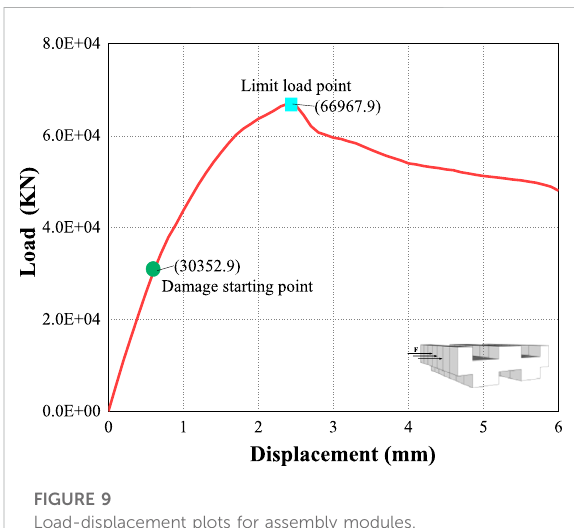
FIGURE 9 Load-displacement plots for assembly